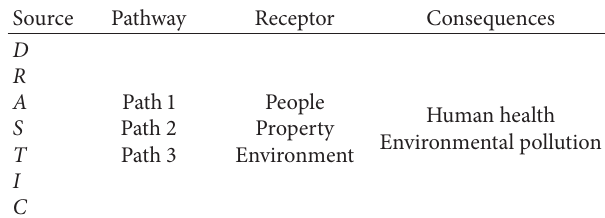
Table 1: S-P-R-C model of groundwater